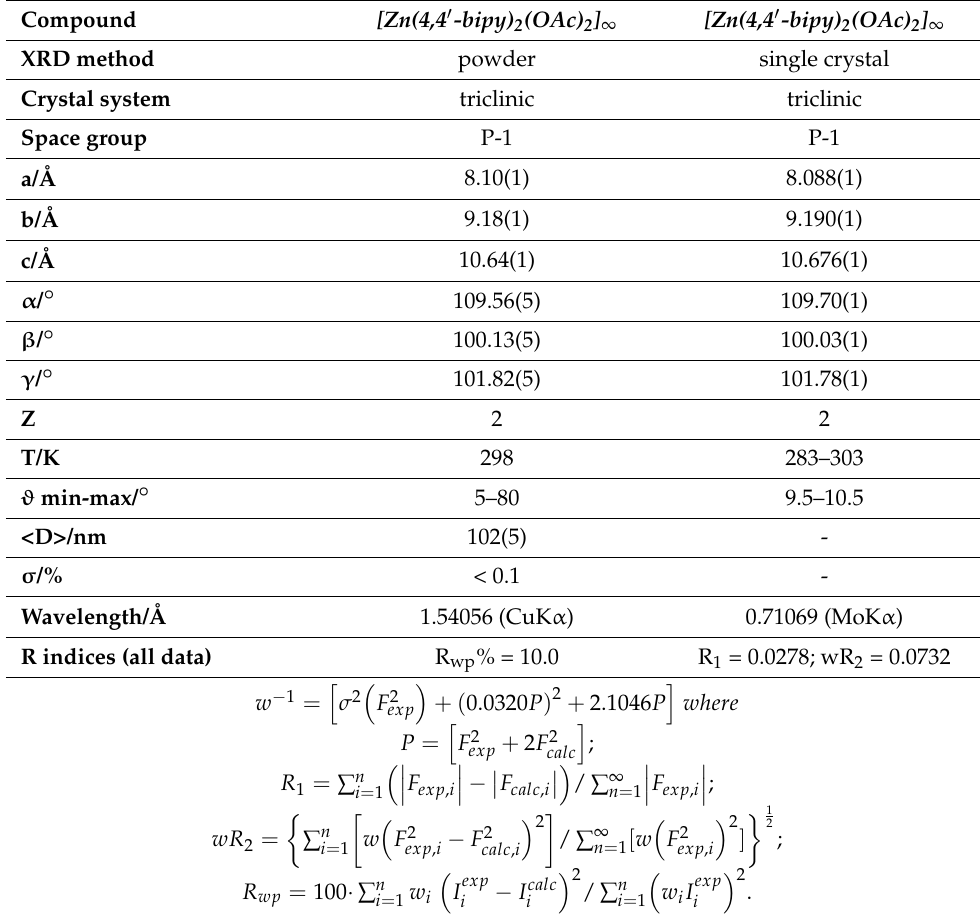
Table 2. Summary of X-ray powder data and structure refinement parameters for compound